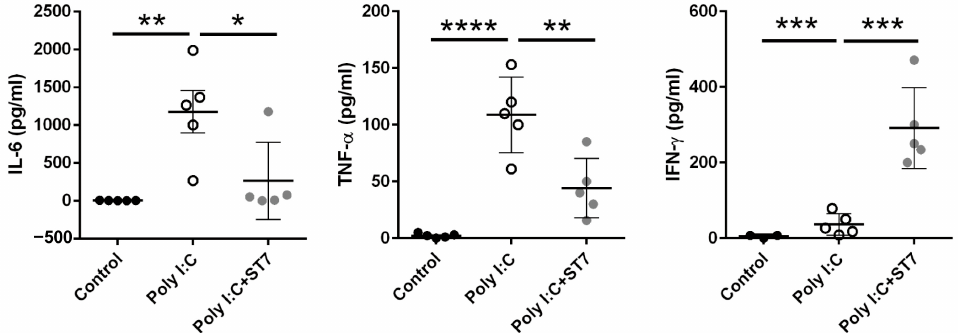
Figure 2. ST7 treatment modulates serum proinflammatory cytokine levels after poly I:C stimulation. Serum samples were collected from control (PBS-treated), poly I:C-treated, and poly I:C+ST7-treated mice. Serum IL-6, TNF- α , and IFN- γ levels were measured after poly I:C stimulation for 2 h. * p < 0.05, ** p < 0.01, *** p < 0.001, **** p < 0.0001.